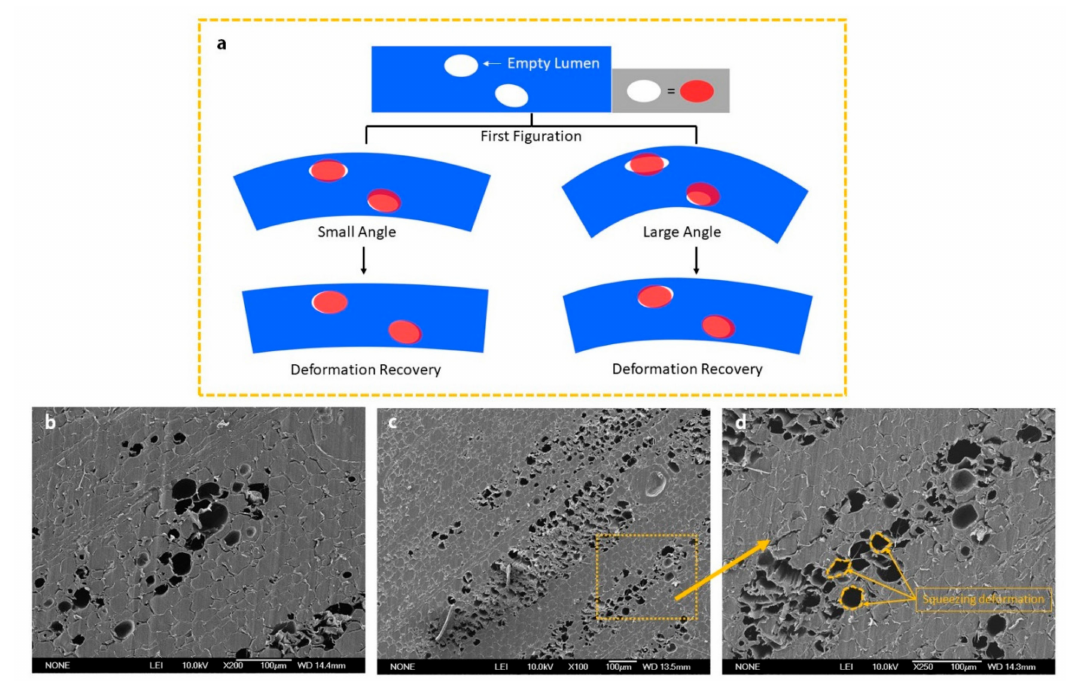
Figure 11. ( a )Graphical illustration of the unrecoverable residual deformation in SMW, where large bending angle results in an increase of residual deformation; ( b ) the SEM image of empty lumina before bending deformation; ( c , d ) the SEM images of empty lumina after bending